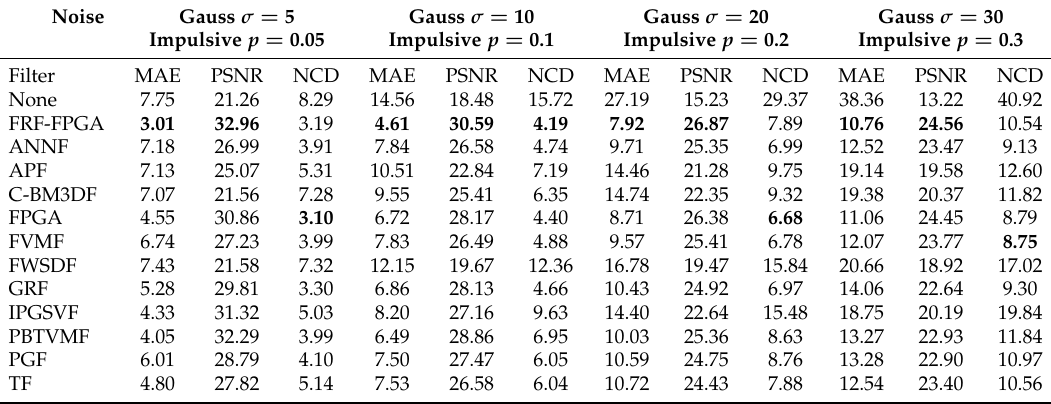
Table 2. Comparative study with some state-of-the-art techniques. Flower test image corrupted with various intensities of mixed noise. Bold values express the best restoration quality.